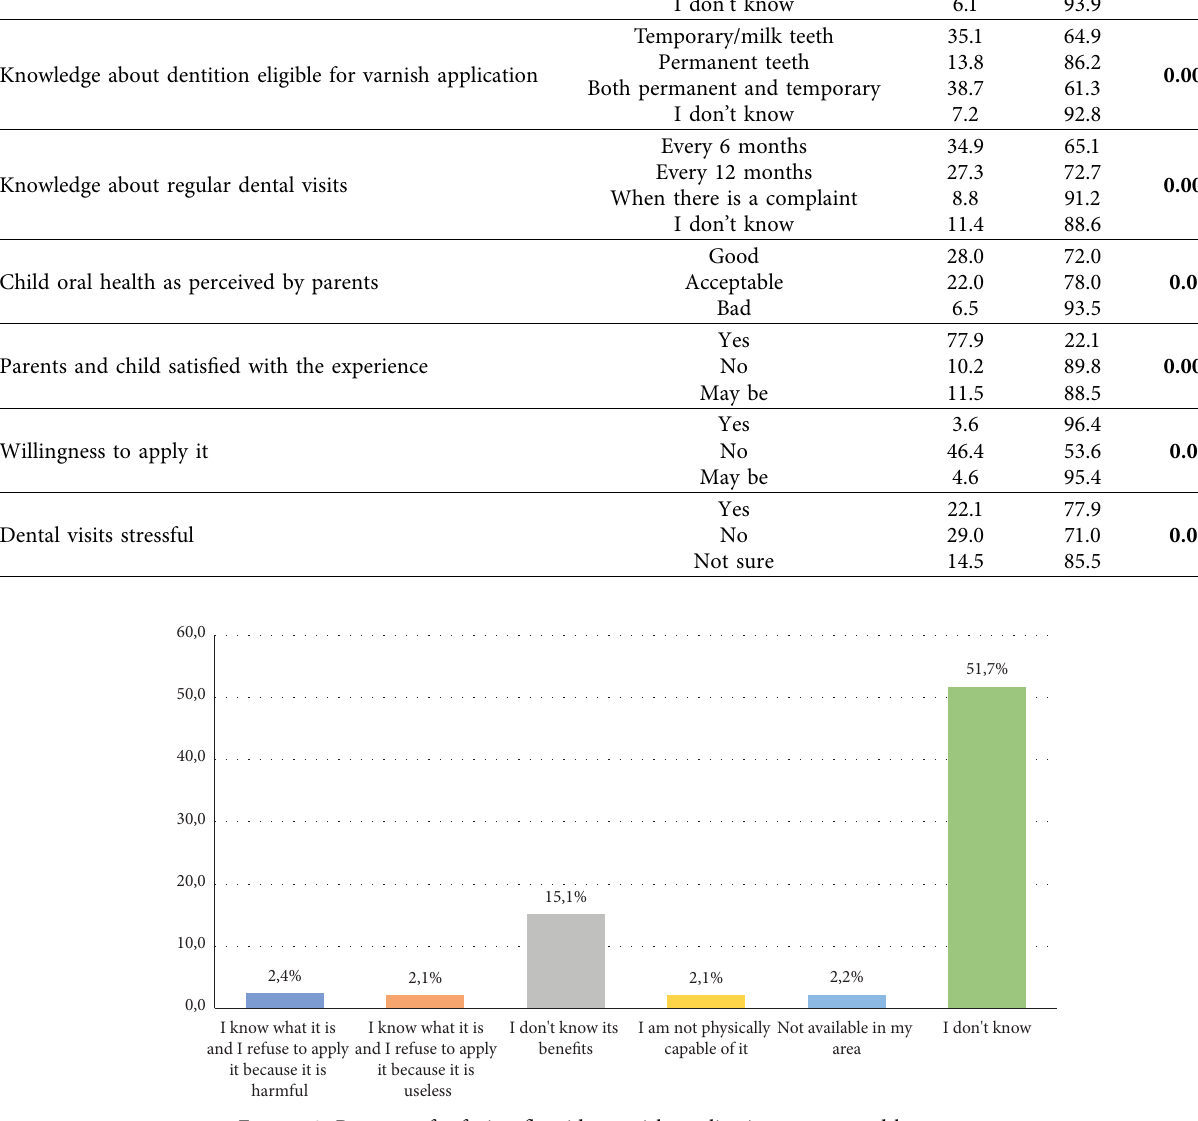
Table 3: Factors associated with fuoride varnish (FV) previous application/use among the study participants. Knowledge about FV